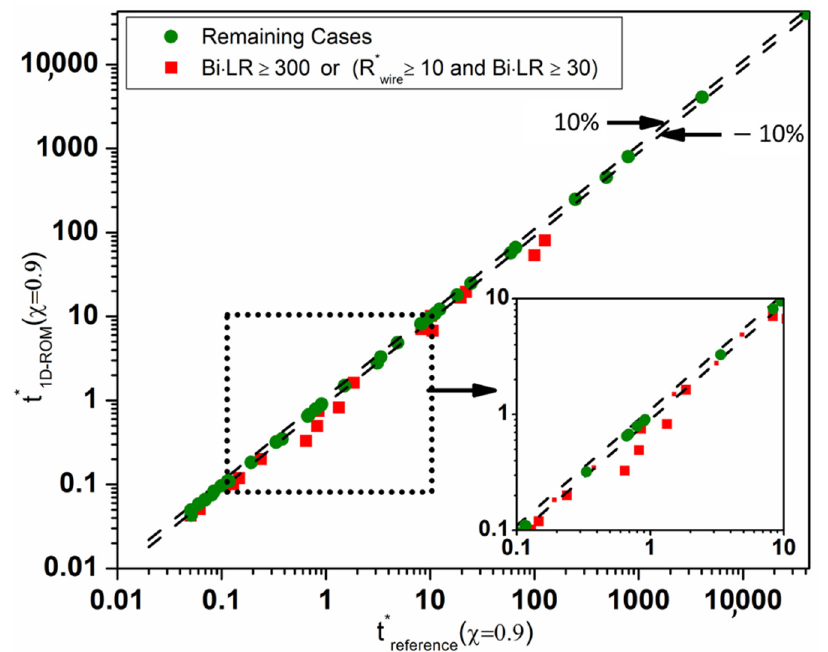
Figure 14. Comparison between 1D ROM and the 2D CFD axisymmetric model for performance parameter.